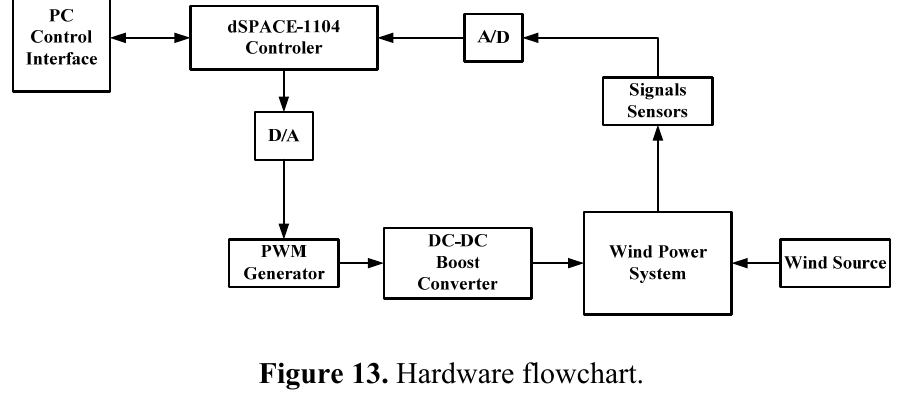
Figure 13. Hardware flowchart.